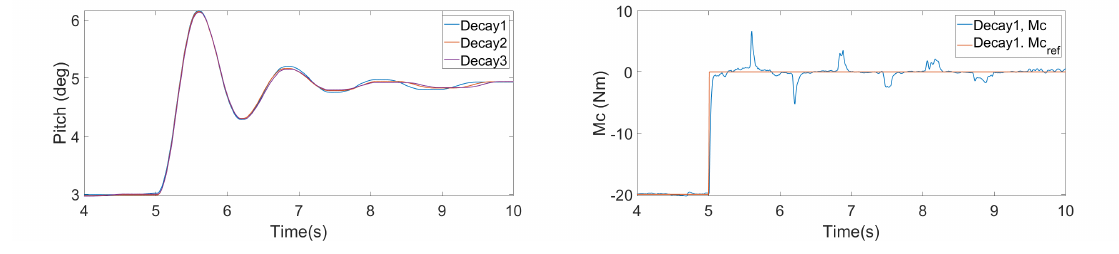
( a ) Decay tests with absorber released at t = 5 s for the ( b ) Target and measured control moment corresponding setup of WEC only. to the first decay test. Figure 8. Example of data for decay tests for the case of WEC only, ( a ) shows the repeatability of the experiment, and ( b ) shows the difference between target and measured control moment due to friction.